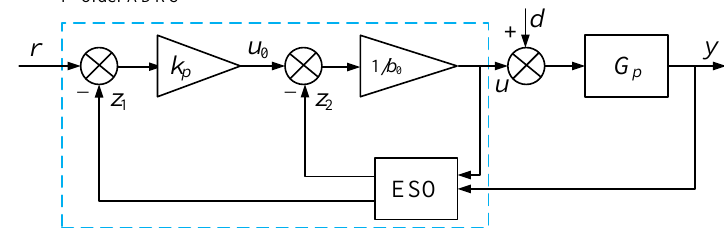
Figure 4. Structure of 1st order active disturbance rejection control.